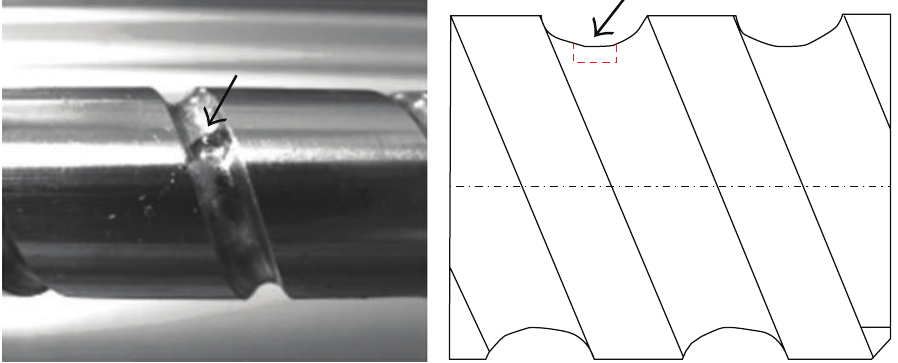
Figure 7: Simulated defects (indicated by an